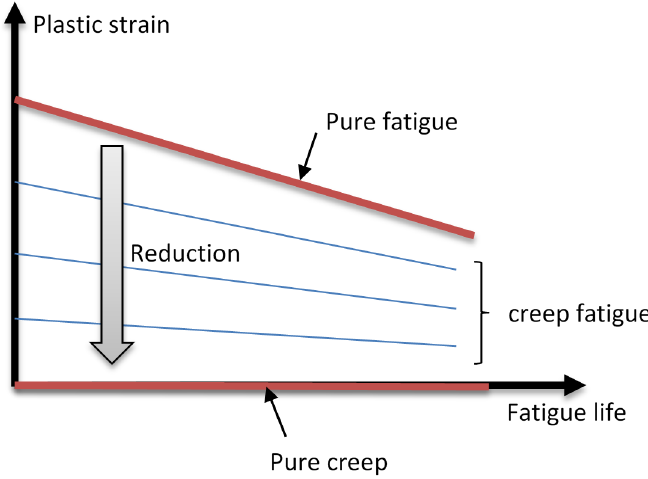
Figure 1. The relation between pure fatigue and pure creep.